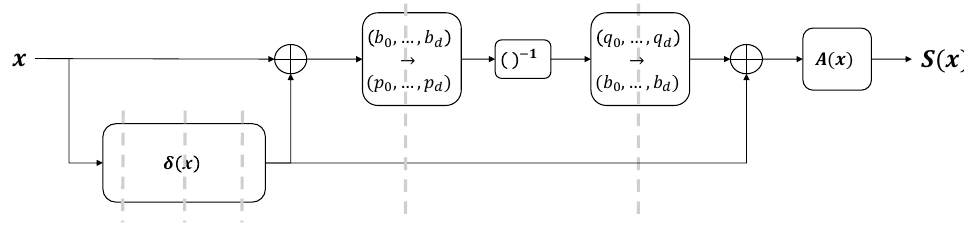
Figure 5: First-order adaptive masking implementation of the AES S-box. The dotted grey lines depict